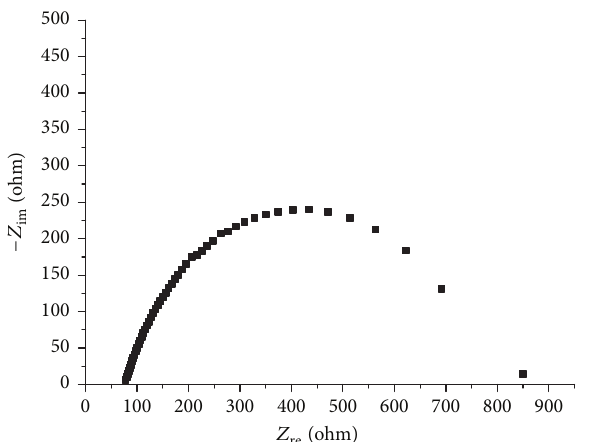
Figure 11: Nyquist plot of specimen number SF3 (28d).